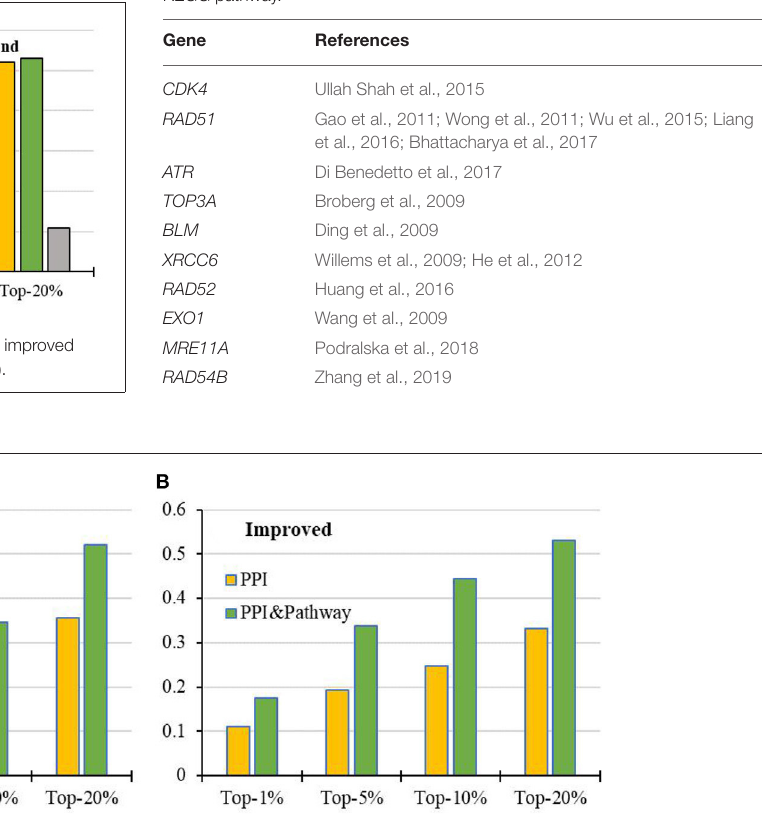
FIGURE 6 | Comparison of top- k Recall ( k algorithm.